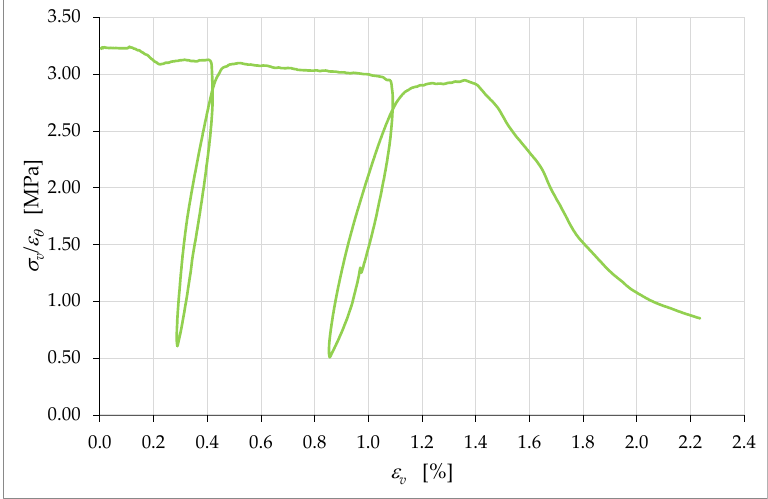
Figure 22. Dependence of the ratio 𝐾 on the axial strain, 𝜀 𝑣 .